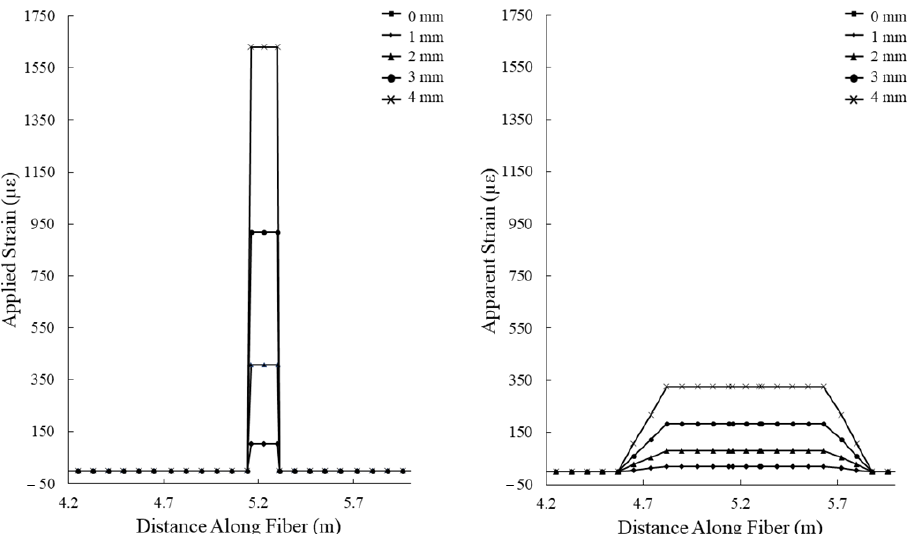
Figure 15. Theoretical applied ( left ) and apparent ( right ) strains incident upon the hybrid optical fiber cable during the shear deformation experiment. Applied shear displacements are from 0.0 to 4.0 mm. Gauge length is 0.3 m, and the kink length noted in the cement beam is 70 mm.